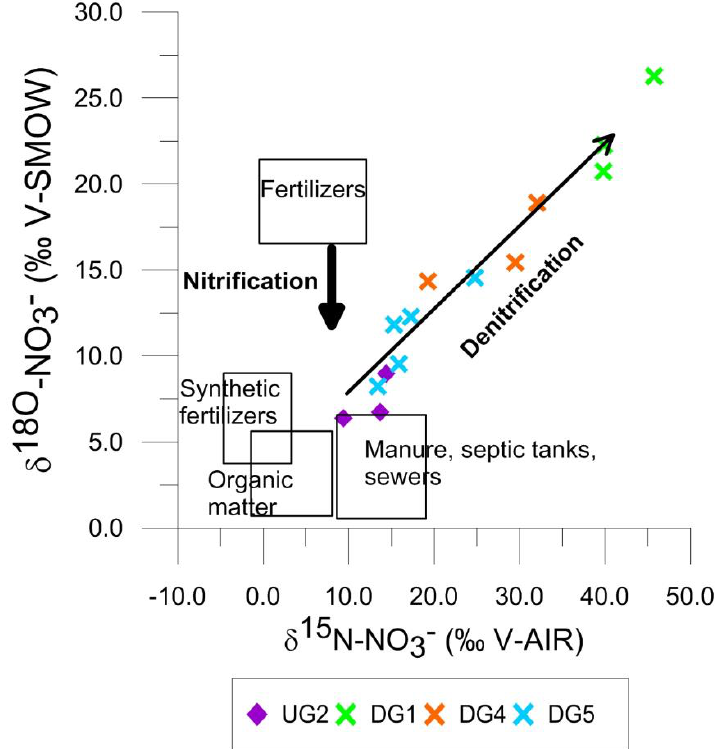
Figure 6. Plot of NH 4+ versus δ 15 N – NH 4+ in samples analysed from MLS located upgradient (UG1), near (HB2) and downgradient (DG1, DG3, DG4, DG5), respectively, with respect to the hydraulic barrier (see Figure 1 for sampling site location).